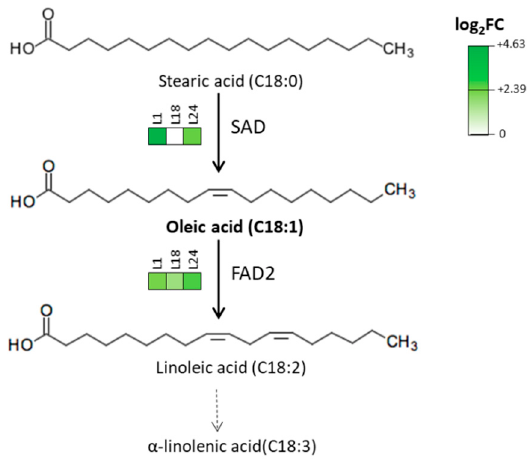
Figure 6. Biosynthesis of oleic acid and average expression levels of the relative genes in AtMYB4oe lines vs. WT.